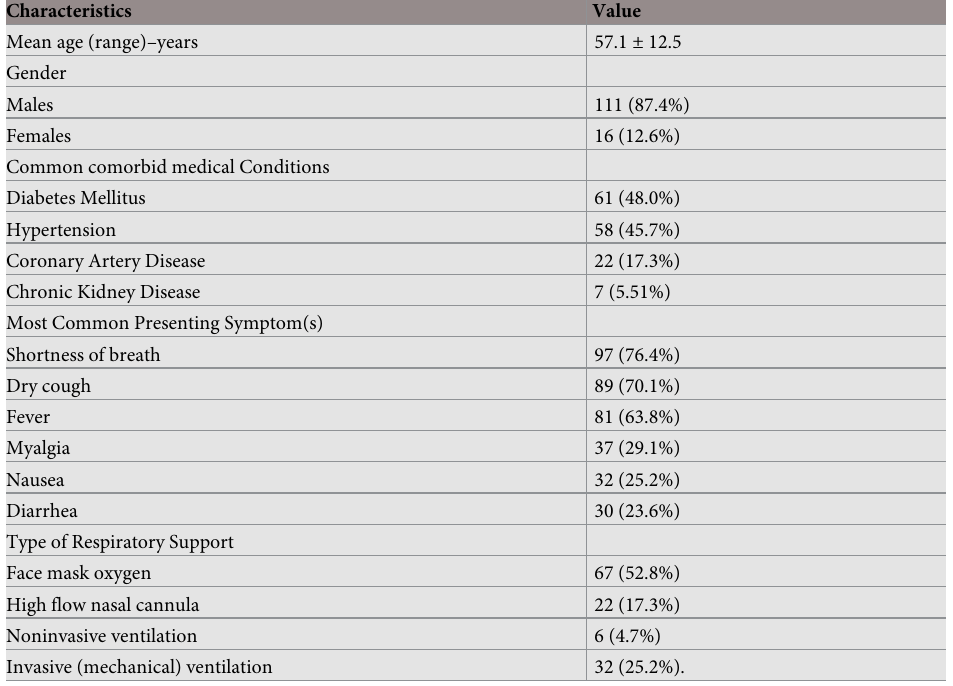
Table 1. Demographic characteristics, most common presenting symptom(s), and type of respiratory support.